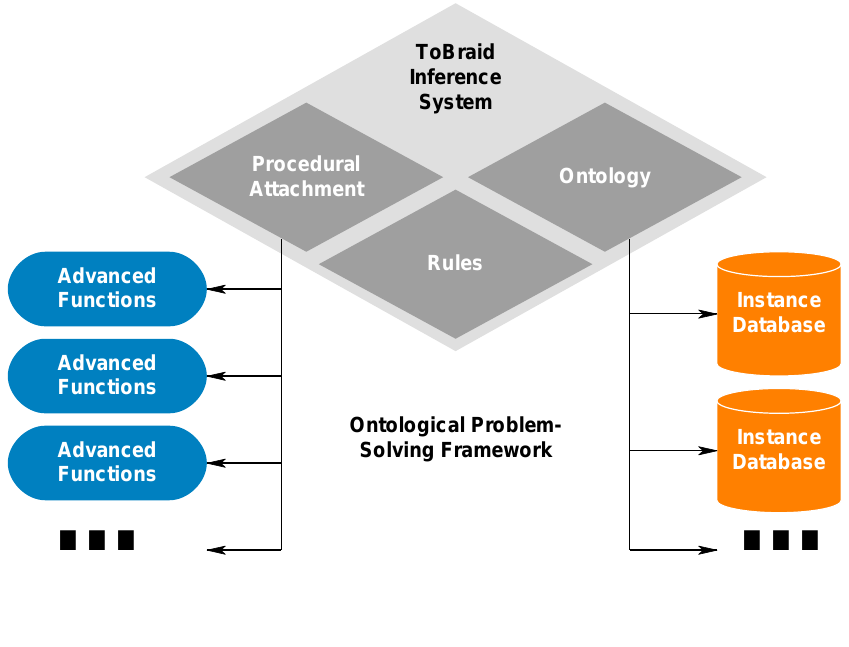
Figure 1. Overview of ontological problem-solving